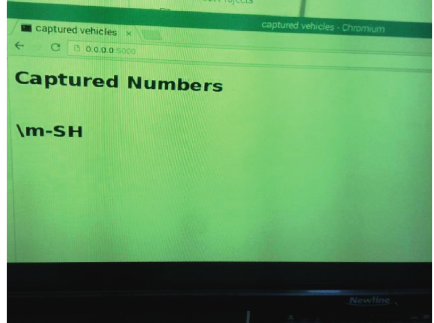
Figure 4: Designed web page for the system.